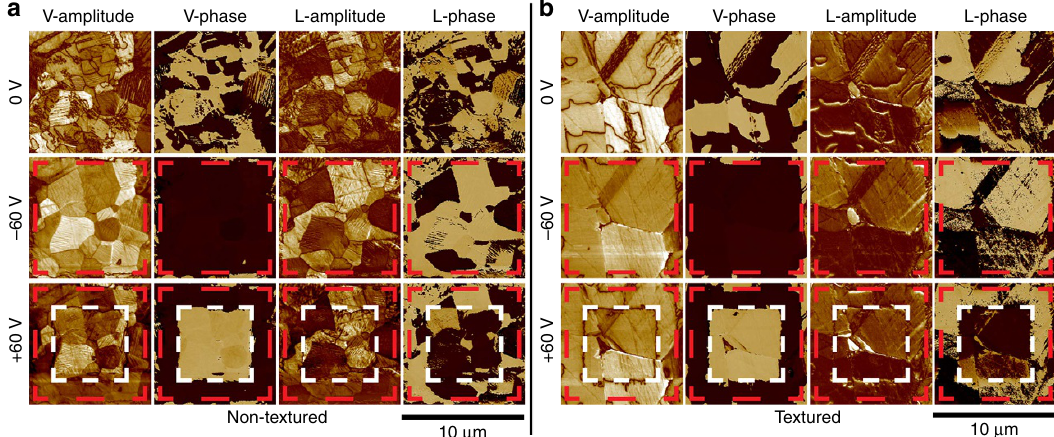
Figure 6 | Domain structures and domain switching. PFM images of ( a ) nontextured and ( b ) textured ceramics. The vertical (V) and lateral (L) PFM was measured under off resonance, f ¼ 17kHz. The dimension of each scanning area is 10 (cid:2) 10 m m. The square area with red dash line border was poled at DC bias of (cid:3) 60V; the square area with white dash line border was poled at